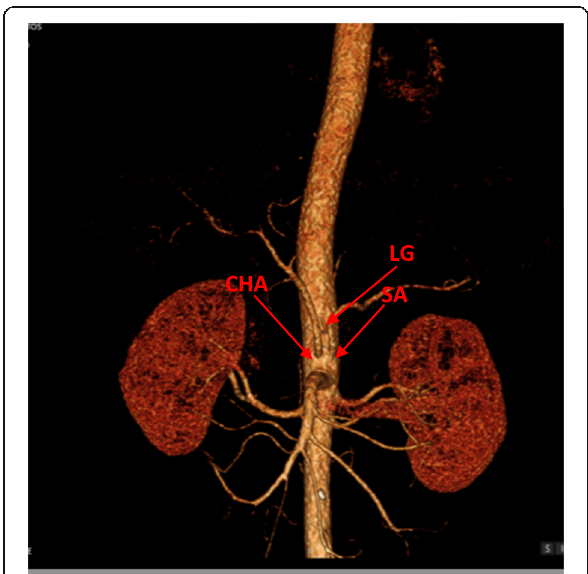
Fig. 3 Coronal CT Angiogram displaying origination of common hepatic artery (CHA), left gastric artery (LGA), and splenic artery (SA), separately from abdominal